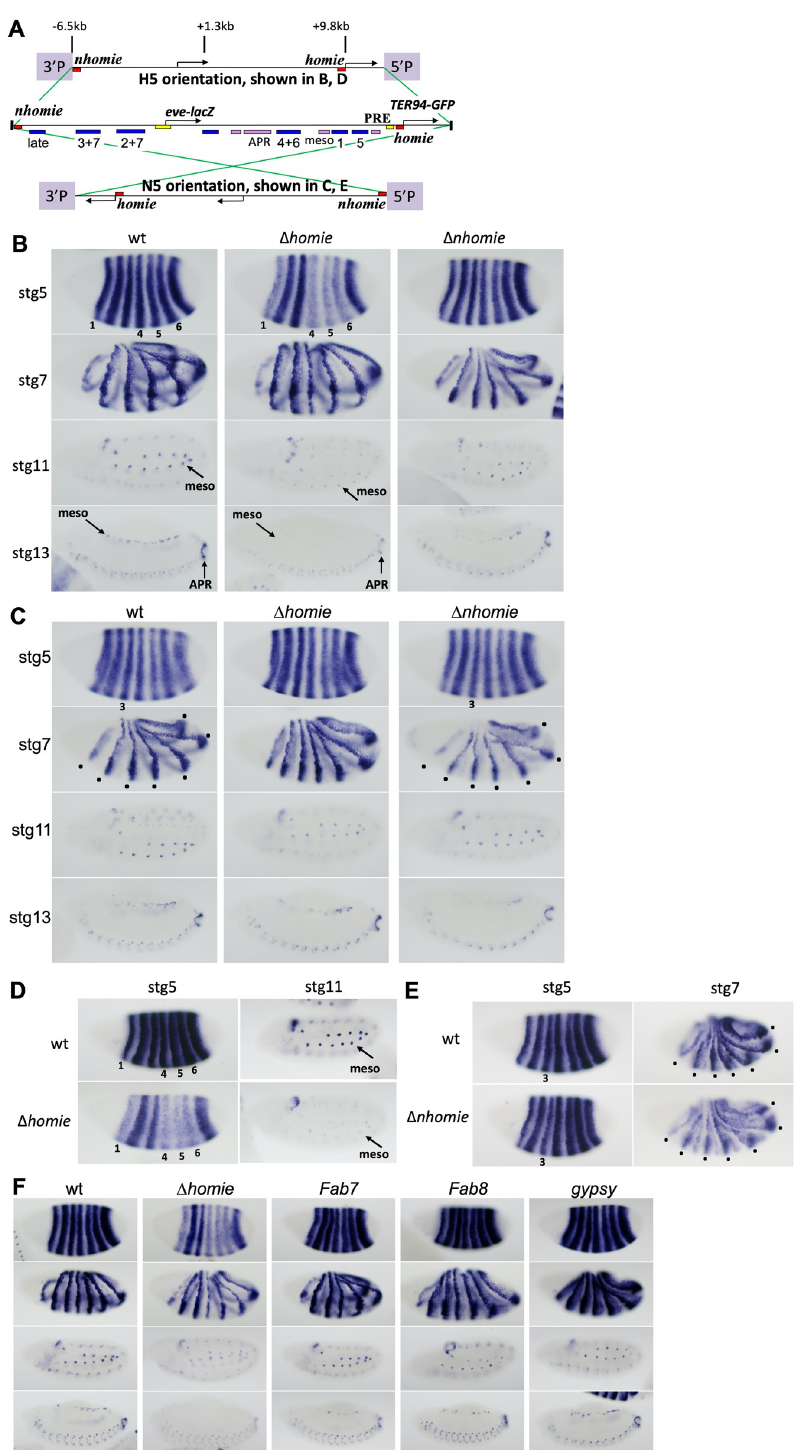
Fig 1. Effects on expression due to eve insulator removal and replacement. (A) Map of the eve pseudo-locus construct (inserted in either orientation, H5 or N5). The wild-type eve and TER94 coding regions were replaced with lacZ and EGFP , respectively. Rectangles represent regulatory elements: red, nhomie and homie insulators; yellow, Polycomb response elements (PREs); blue, embryonic stripe enhancers labeled with either numbers for early stripes, or “late” for the 7 later stripes; pink, tissue specific enhancers for: APR, anal plate ring; meso, mesoderm (other known elements are either unlabeled or not included). 5’P and 3’P: 5’ and 3’ P-element ends, part of the attP site